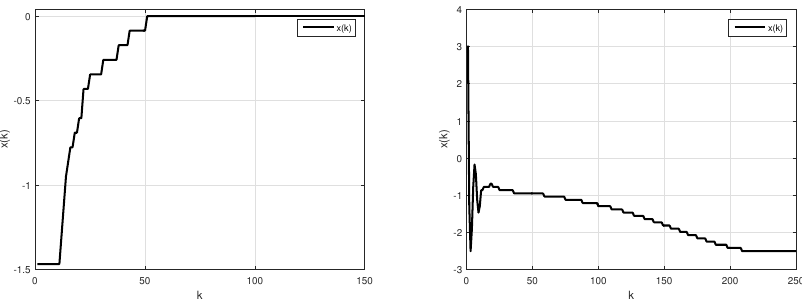
Figure 3. Dynamics evolution of x ( k ) for initial condition x ( k ) = 100